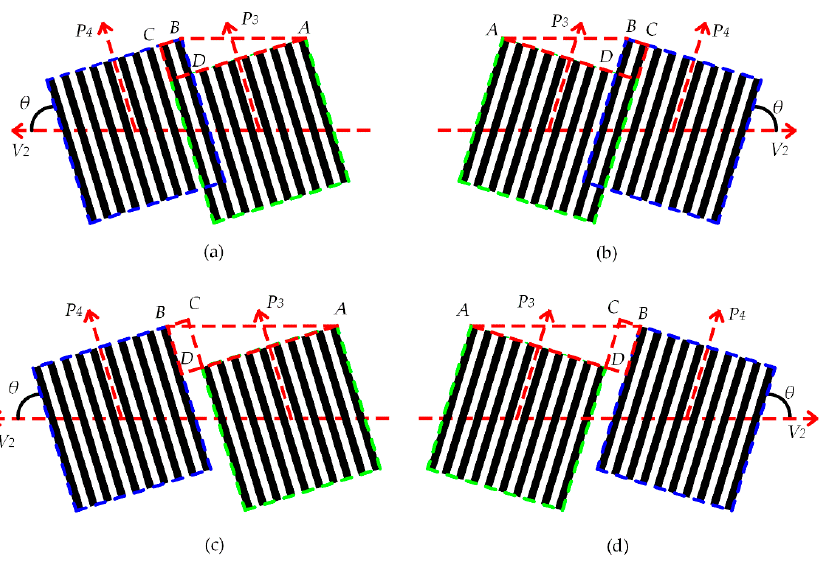
Figure 3. Several grating images obtained at different angles: ( a ) Leaning to the left and overlap phenomenon, overlap value is − BC/sin θ ( b ) Leaning to the right and overlap phenomenon, overlap value is − BC/sin θ ( c ) Leaning to the left, and the interval distance value is BC/sin θ ( d ) Leaning to the right, and the interval distance value is BC/sin θ .